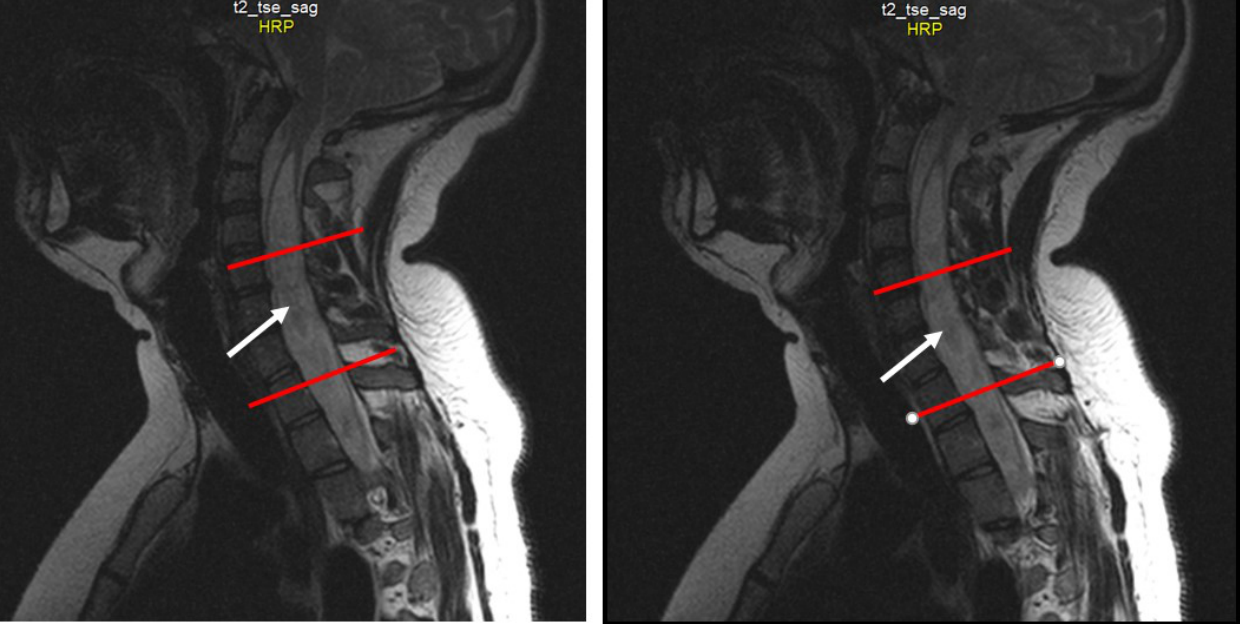
Figure 3. Sequential sagittal T2-weighted MRI scans of the cervical spine demonstrate the syrinx (white arrow) from the level of C2 extending inferiorly into the thoracic spinal cord, with the greatest dilation around C5-Th1 (between the red lines).